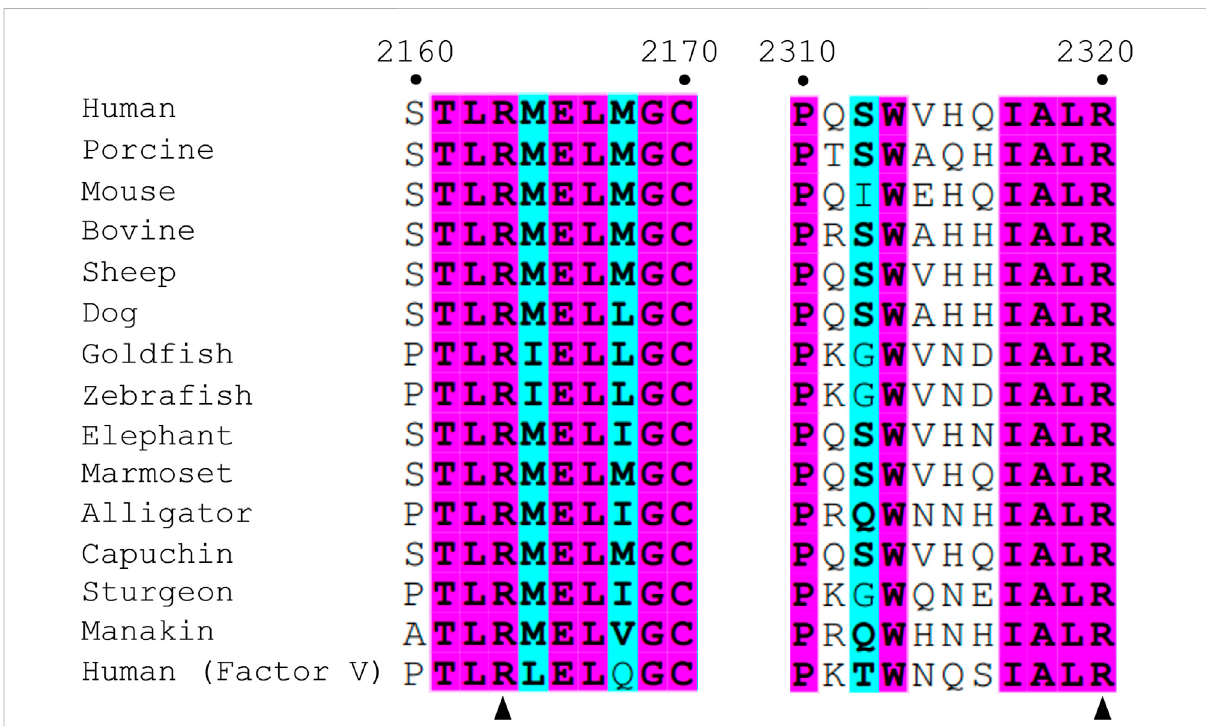
FIGURE 2 SequencealignmentoffVIIIamongvarious speciesandfV. NumberingisbasedonhumanfVIIIresidues.Similarresiduesarehighlightedincyan and wholly conserved residues are highlighted in magenta. Arrows point to two conserved arginine residues, R2163 (C1 domain) and R2320 (C2 domain), within the scope of the